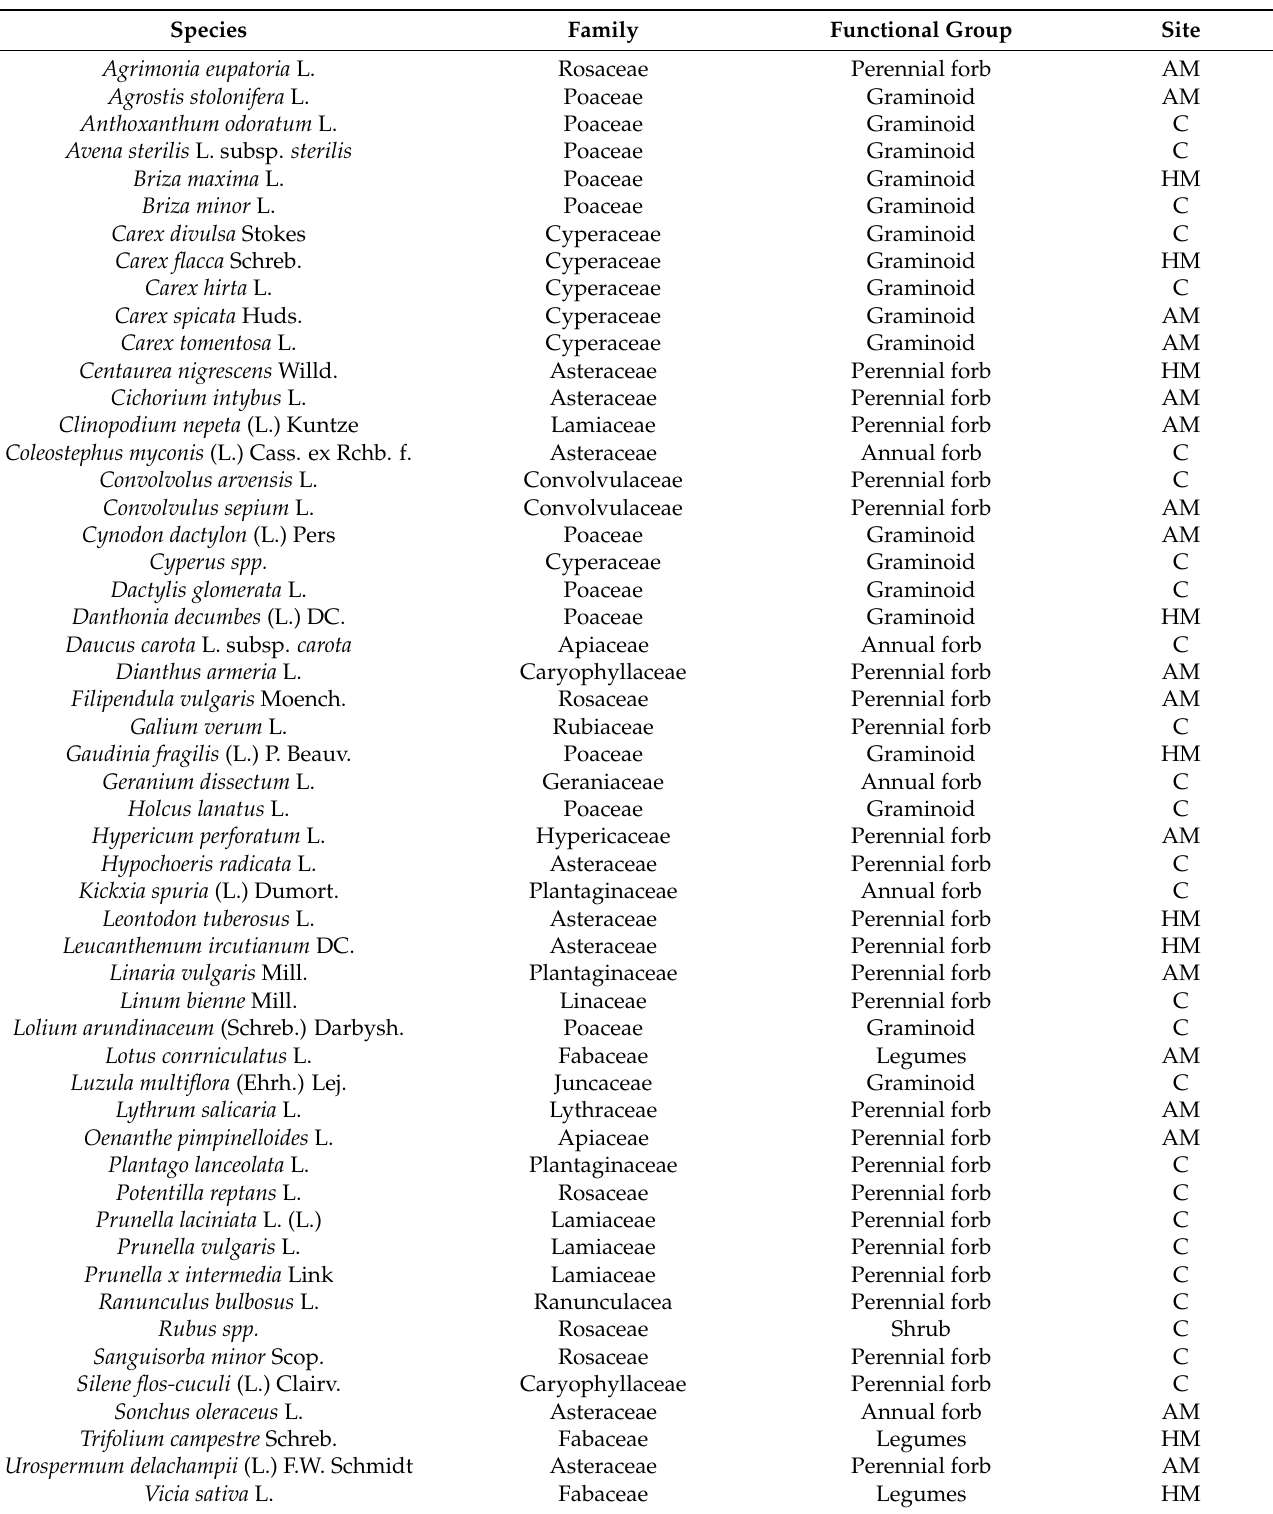
Table 1. Species present in the meadow, family, and functional groups [35]. AM = exclusive after the abandonment; HM = exclusive to the hay meadow; C =